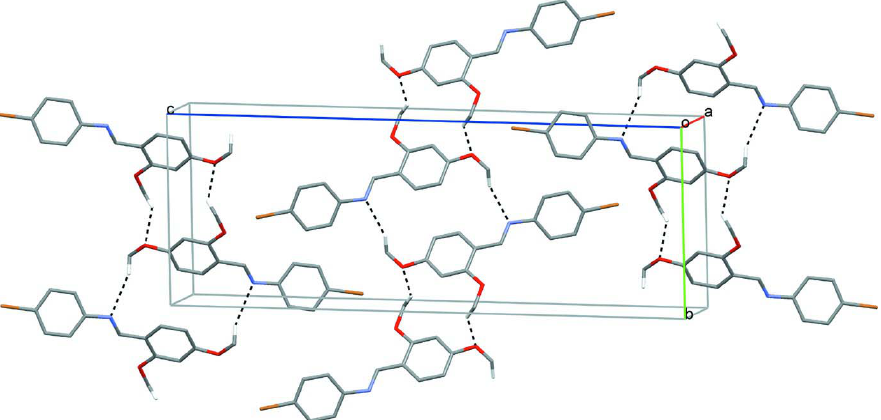
Figure 2 Crystal packing of (I) viewed down the a axis with hydrogen bonds drawn as dashed lines. H atoms not involved in hydrogen bonding have been